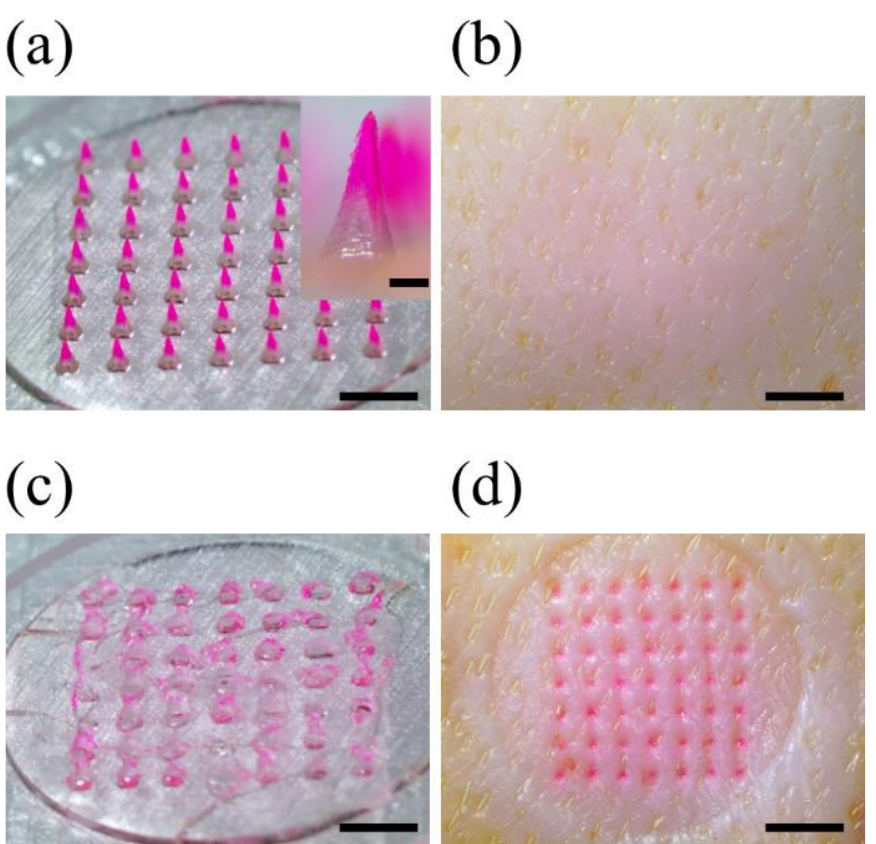
Figure 5. Skin penetration test of DMP into the porcine skin ex vivo. The images of DMP before ( a ) and after ( c ) the skin penetration, and the porcine skin ex vivo before ( b ) and after ( d ) the DMP skin penetration.